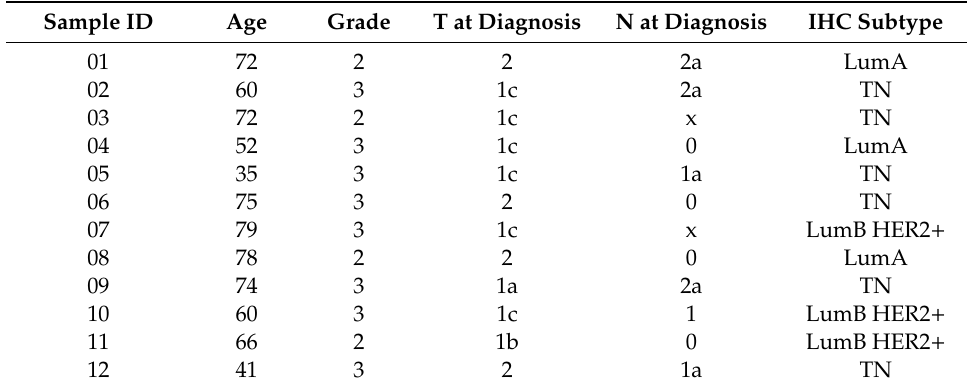
Table 1. Clinical characteristics of breast cancer